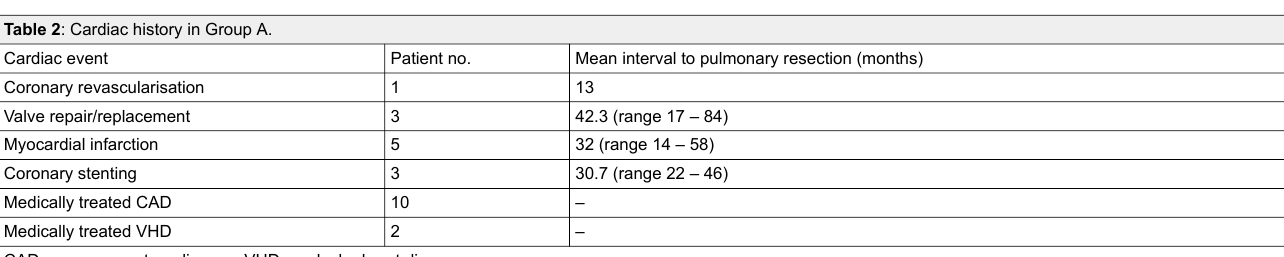
CAD = coronary artery disease; VHD = valvular heart